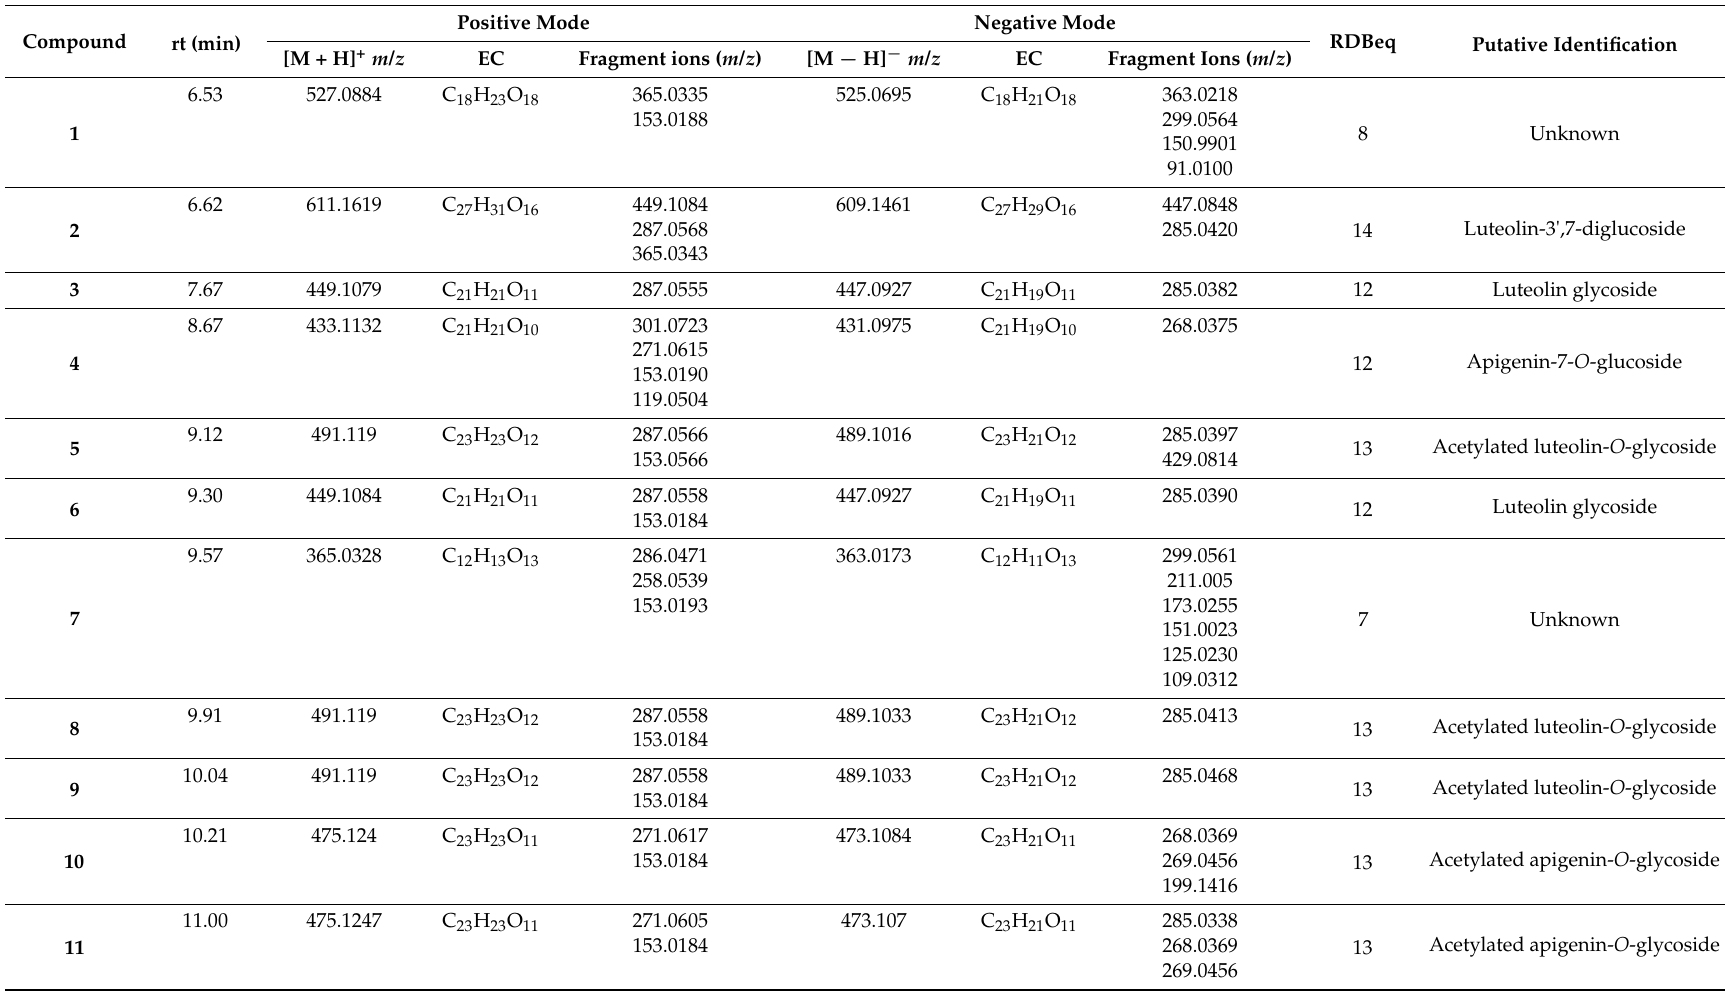
Table 2. Compounds identified in RL3-MeOH extract by Ultra Performance Liquid Chromatography-Mass Spectrometry